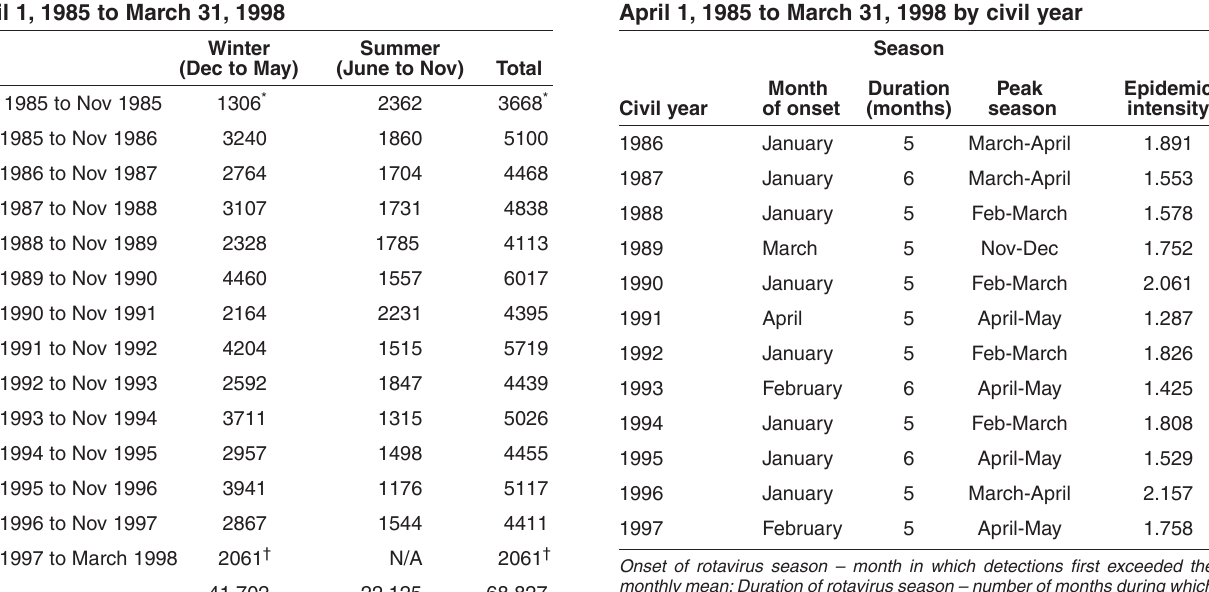
TABLE 2 Diarrhea-related hospitalizations (all diagnoses) among children younger than five years of age in